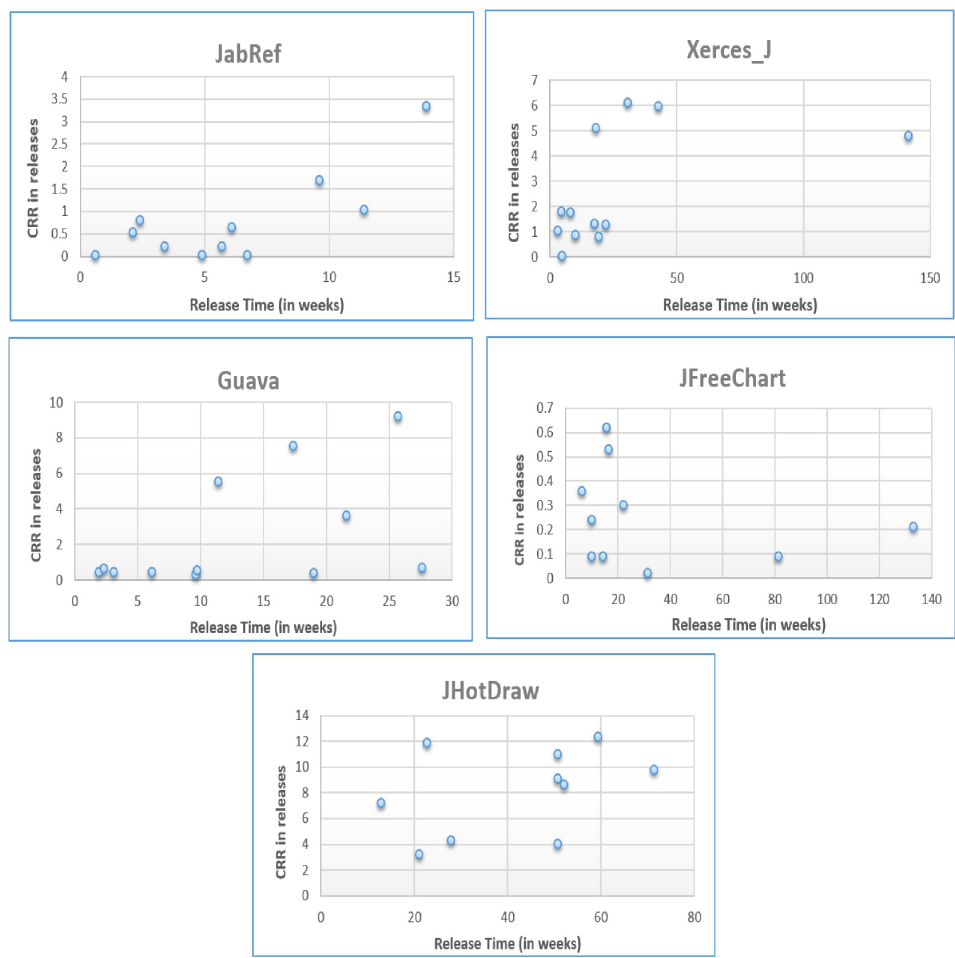
Fig 7. Clone refactoring ratio and release time duration for five Java